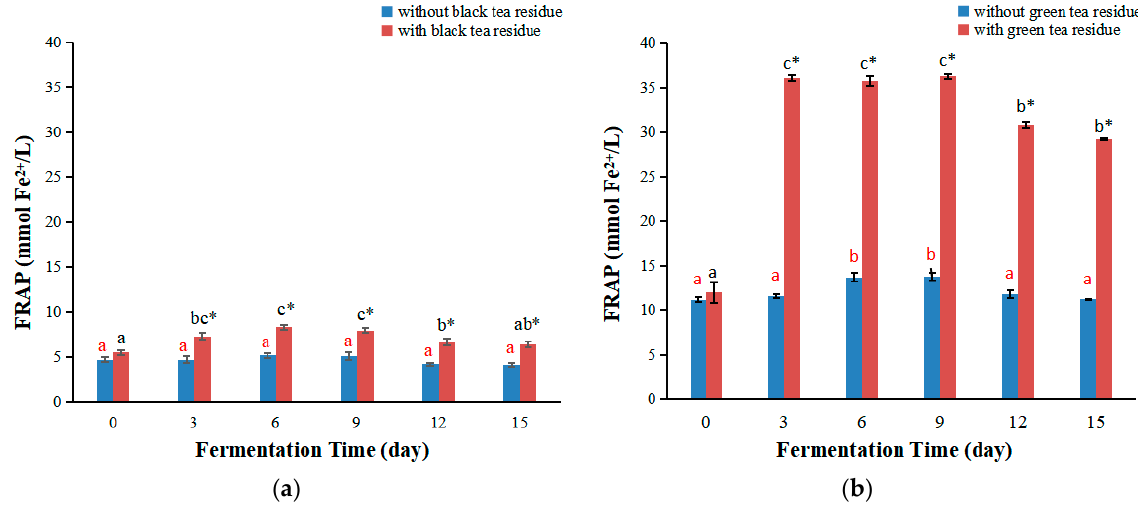
Figure 2. Changes of FRAP values of kombucha produced by fermentation with or without tea residue at different fermentation stages. ( a ) FRAP values of kombucha from black tea; ( b ) FRAP values of kombucha from green tea. Different letters illustrate significant differences ( p < 0.05) for the same kombucha beverage at different fermentation times, and the same letter represents no significant difference ( p > 0.05). Different colors of letters represent different kombucha fermentation with tea residue or without tea residue. * Indicates significant difference ( p < 0.05) between kombucha fermentation with tea residue and kombucha fermentation without tea residue at the same fermentation time.